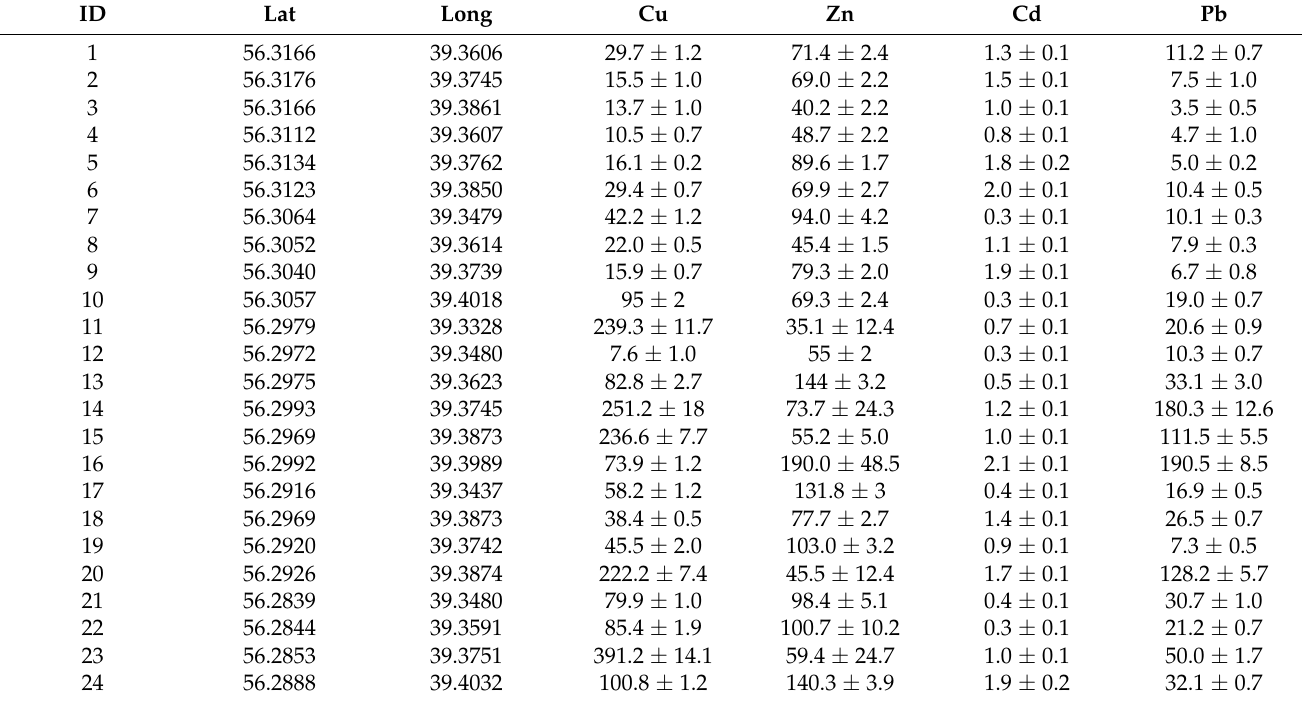
Table 1. The mass fractions mg/kg of the obtained elements and the corresponding locations.